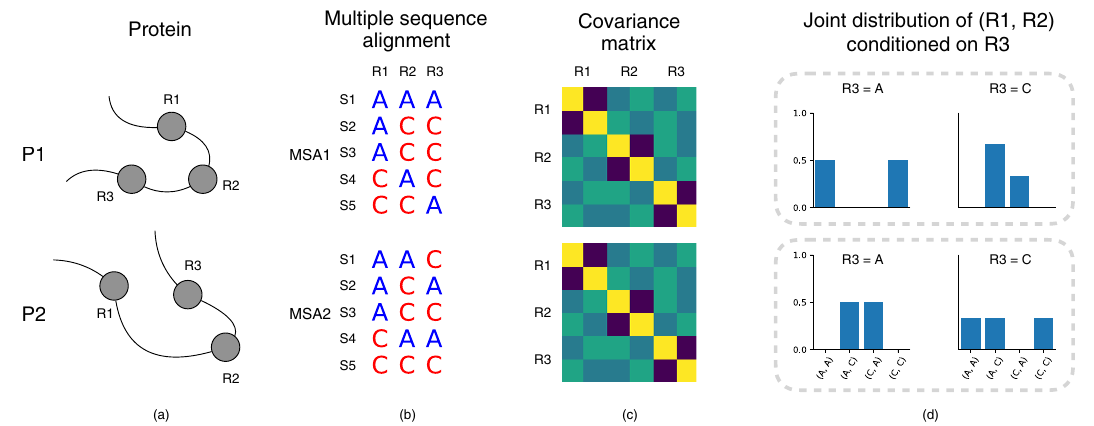
Fig. 1 The limitation of the covariance-based methods in estimating inter-residue distances. a Two artifactual proteins P 1 and P 2 . In protein P 1 , two residues R 1 and R 2 are close, whereas in protein P 2 , they are far from each other. b The MSAs constructed for the two proteins show considerable difference. c The covariance matrices calculated from these two MSAs are totally identical; thus, the covariance-based methods give the same estimation of inter-residue distances for protein P 1 and P 2 . This is contradict the true inter-residue distances. d Unlike the covariance matrices, the conditional joint- residue distribution P ( R 1 , R 2 ∣ R 3 ) could effectively distinguish these two MSAs.